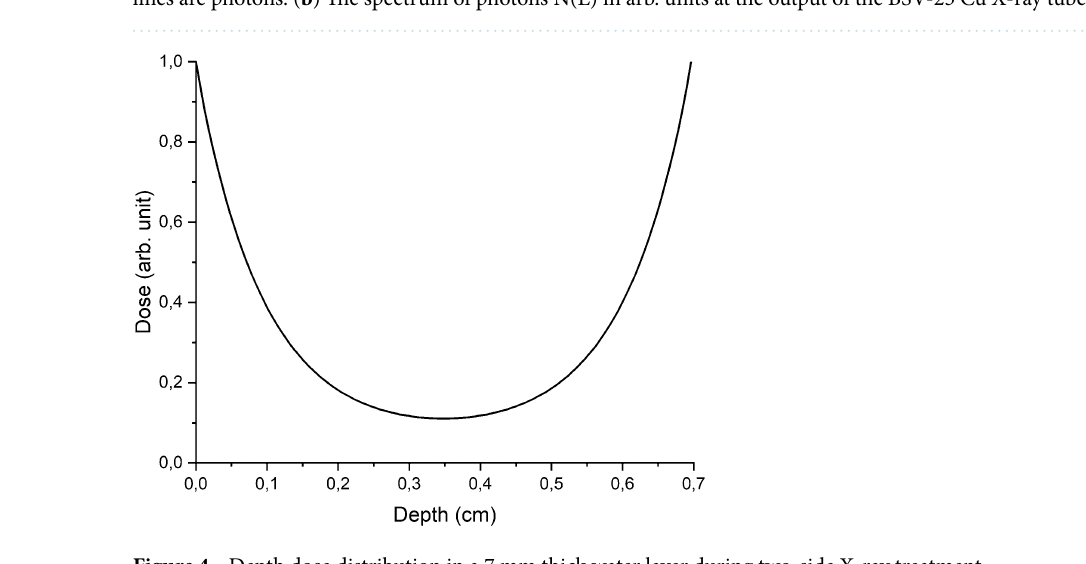
Figure 4. Depth dose distribution in a 7 mm thick water layer during two-side X-ray